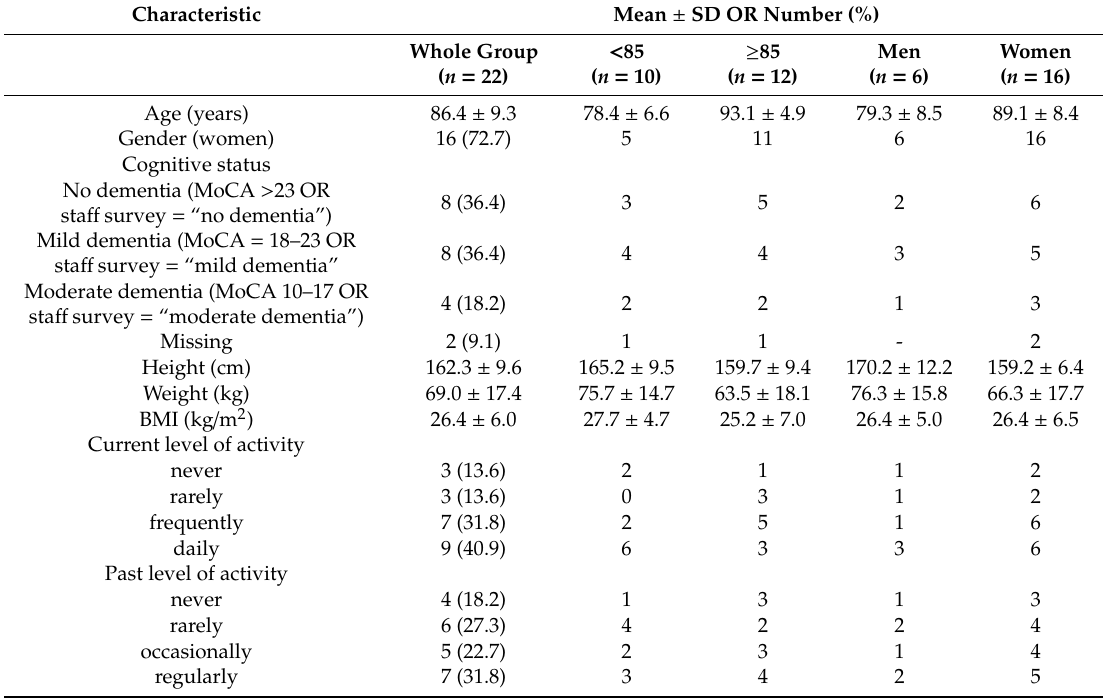
Table 1. Characteristics of the population ( n = 22; Mean ± SD OR number